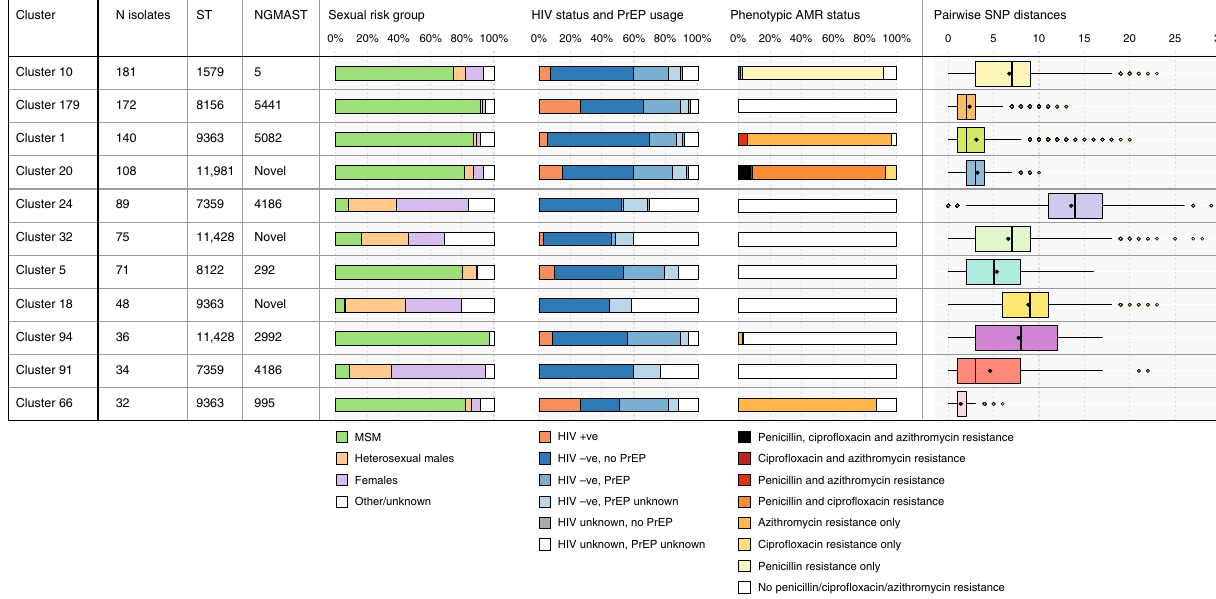
Fig. 3 Associations of major Neisseria gonorrhoeae clusters with epidemiological risk factors and antimicrobial susceptibility pro fi les. Major clusters are de fi ned as those containing 30 or more cases. The median pairwise single nucleotide polymorphism (SNP) distance represents the overall diversity within each cluster, with each cluster containing isolates that are related by ≤ 10 SNPs using a hierarchical single-linkage clustering approach. Box plots indicate median and interquartile range (IQR), with the whiskers representing the highest and lowest values within 1.5 × IQR of the upper and lower quartiles, and the dots representing outlier values. Abbreviations : MLST multilocus sequence type, NG-MAST Neisseria gonorrhoeae multi-antigen sequence types, MSM men who have sex with men, PrEP pre-exposure prophylaxis, AMR antimicrobial resistance, SNP single nucleotide polymorphism